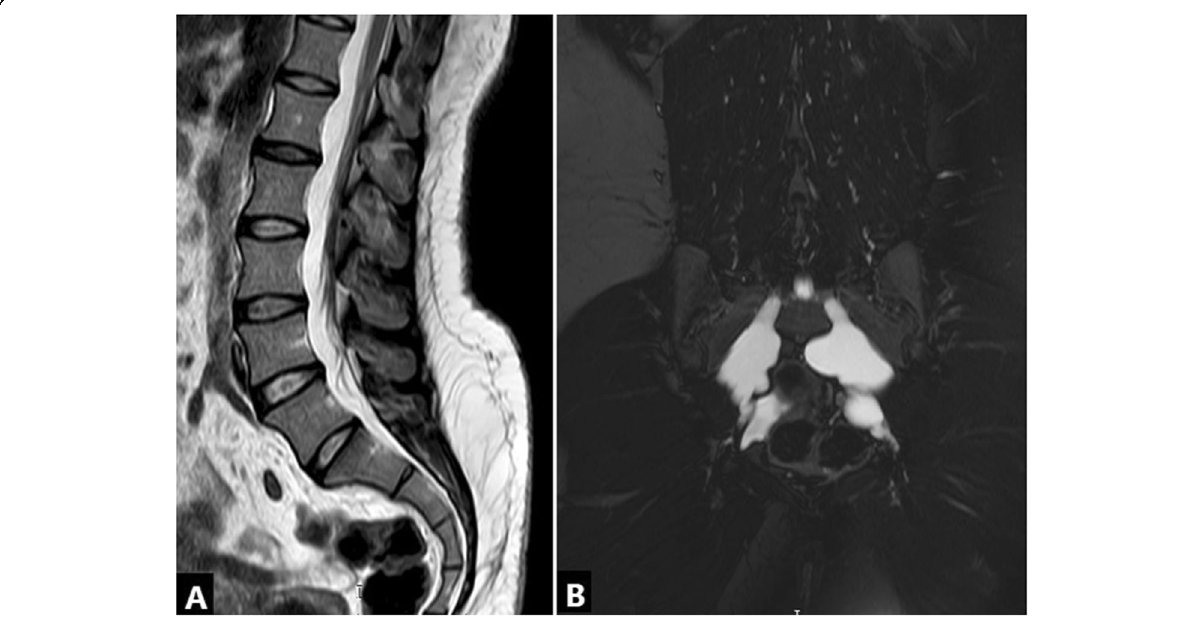
Fig. 6 A 32-year-old female patient, presenting with bilateral sciatica. a Routine MR protocol images are normal. b Additional coronal STIR images revealed bilateral large perineural cysts (Tarlov cysts) along the course of the sacral nerve roots associated with bone